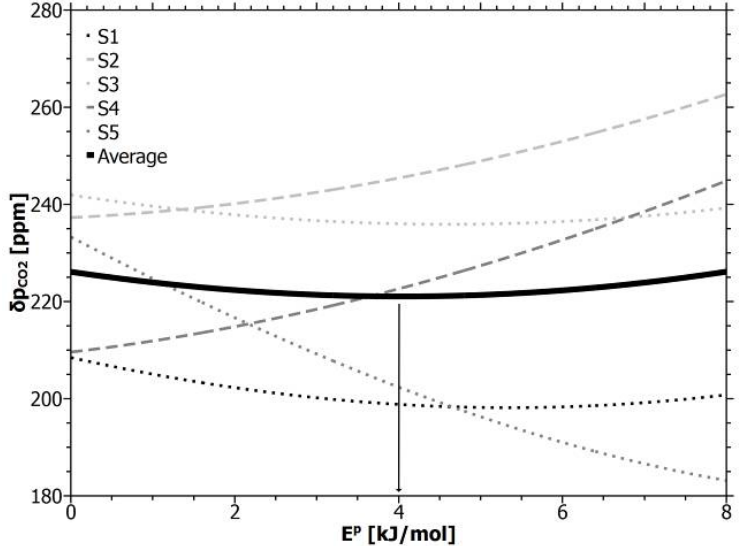
Figure 7. Accuracy of temperature-compensated line-sensors S1 − S5 in dependence to the simulated activation energy E p . For E p = 0 the shown accuracy corresponds with the data in Table 2. The arrow marks the minimum of the average over individual accuracy